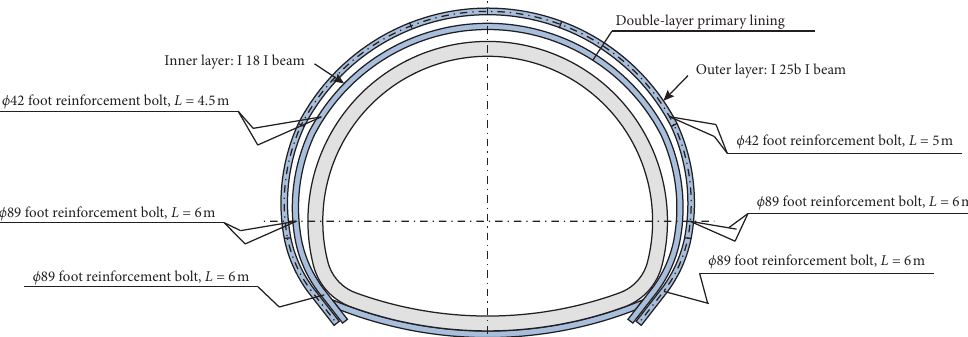
ϕ 42 foot reinforcement bolt, L = 4.5m